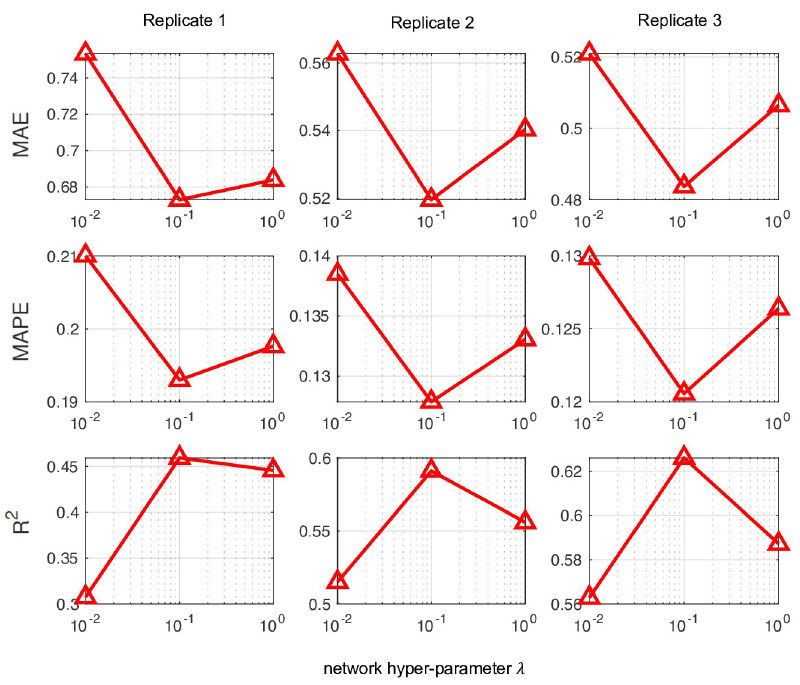
Fig 9. Imputation performance of FIST on mouse tissue replicates by varying network